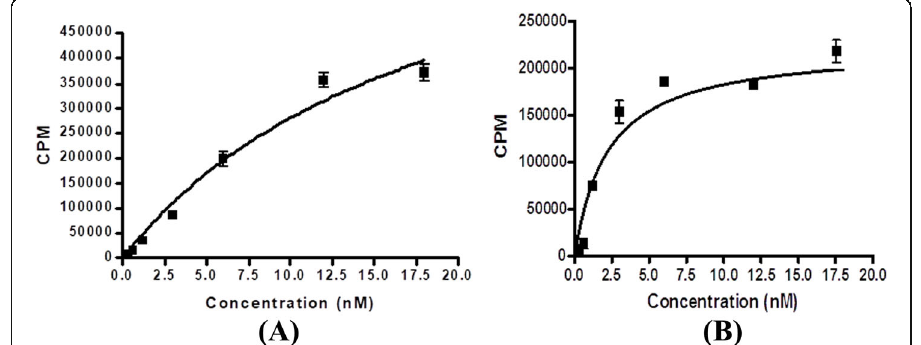
Fig. 2 Determination of binding affinity ( K d ) values ( n = 3) of MUC1-[ 18 F] SFB (A) and MUC1-FA-[ 18 F] SFB hybrid peptide conjugates in MCF7 breast cancer cell